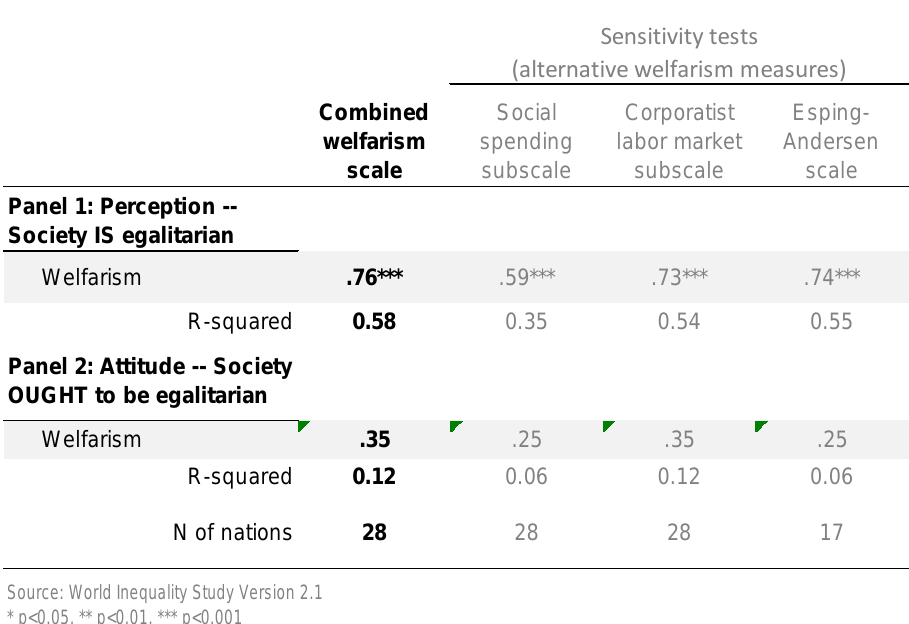
Figure 9. Image of society: How egalitarian is is now? How egalitarian OUGHT it be? Effects of welfarism: Standardized OLS regression coefficients. Aggregate data for 28 nations, 1987–2009.